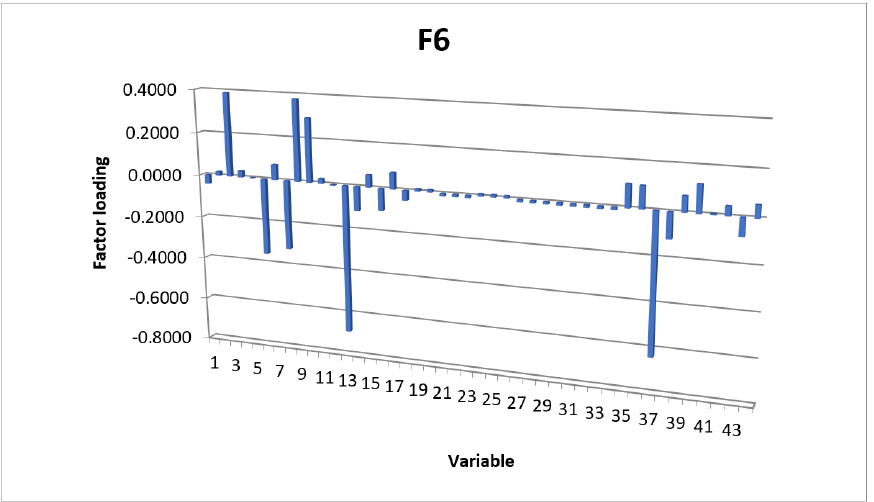
Figure 11. Graphic depiction of factor loads values for input variables for factor F6.